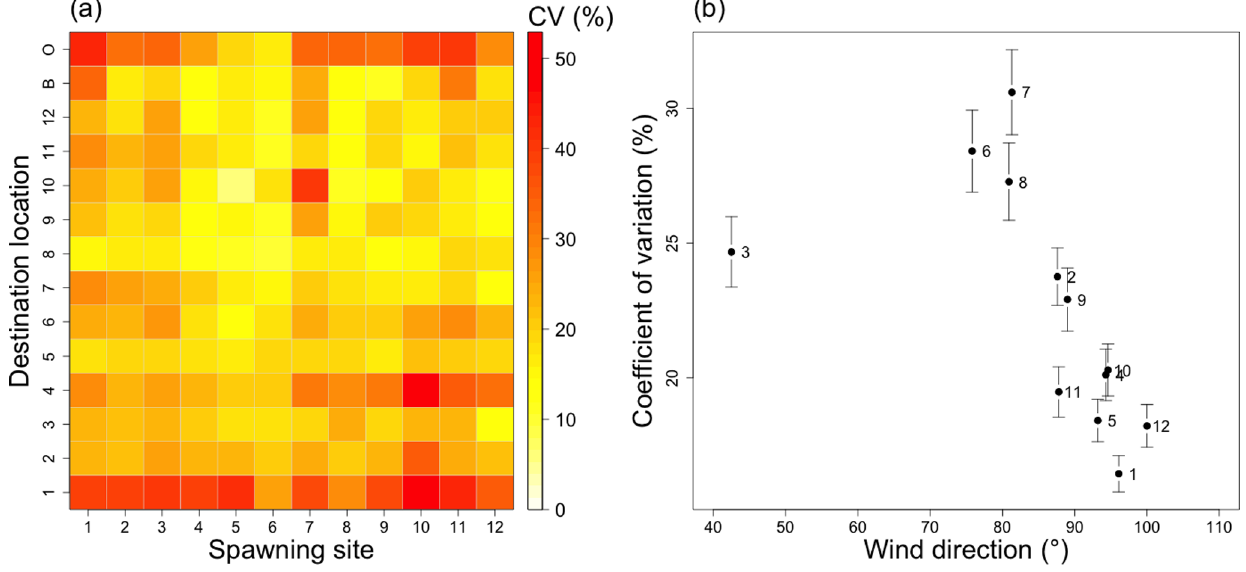
Figure 8. Connectivity variation (CV, %), according to PLD. The mean connectivity variations coefficients are calculated according to the PLD factor ( i.e. , considering 15, 20, 25 and 30 days), by dividing the connectivity standard deviation calculated according to the PLD factor by the average. The matrix (a) is used to represent the spatial variability of CV, during mean wind conditions (average of the 12 wind scenarios). The graph (b) represents the CV variability according to wind direction. In the latter case, the error bars represent the spatial standard deviation. The numbers on graph (b) correspond to the wind regime indices (see Table 4).